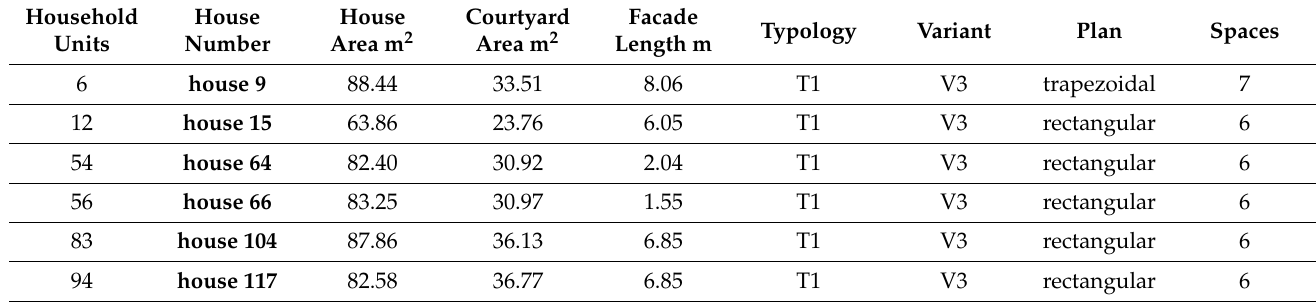
Table 4. Variant 3.